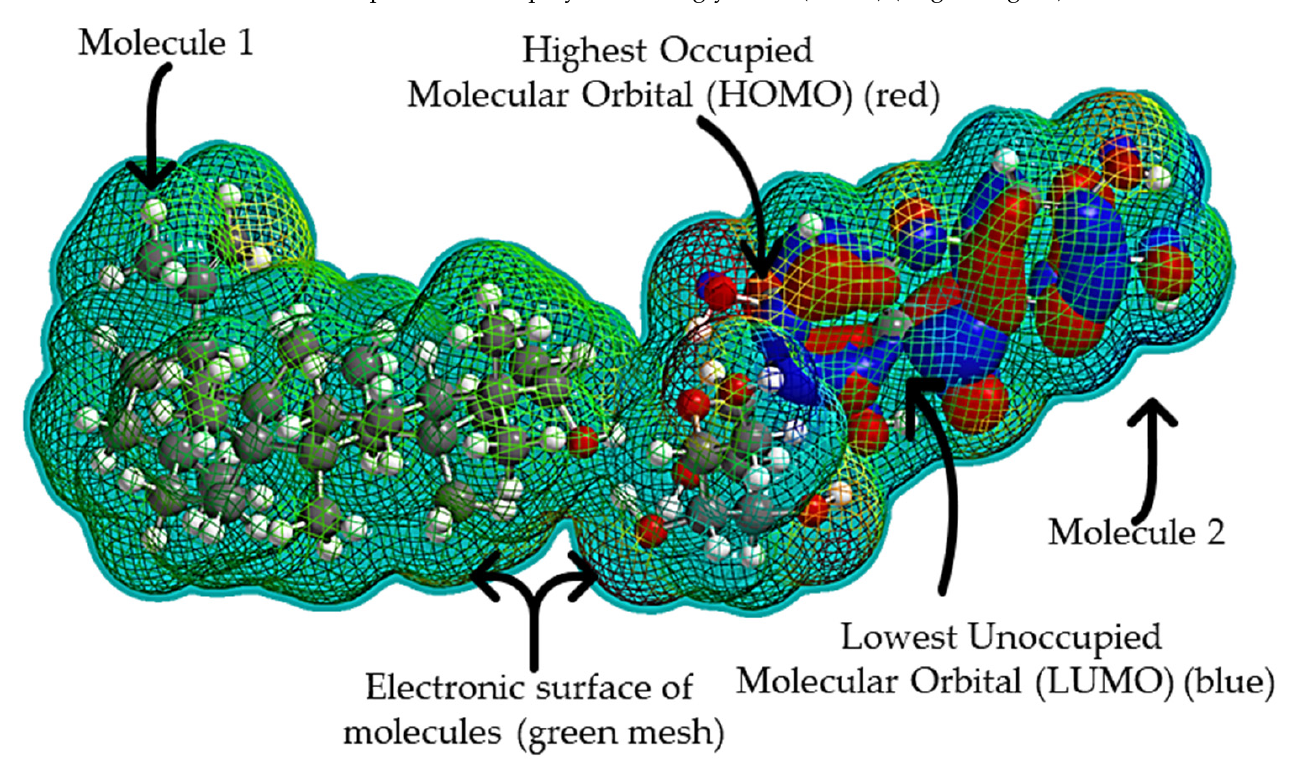
Figure 4. Example of HOMO and LUMO surface in the interaction of two molecules from different chemical characteristics.